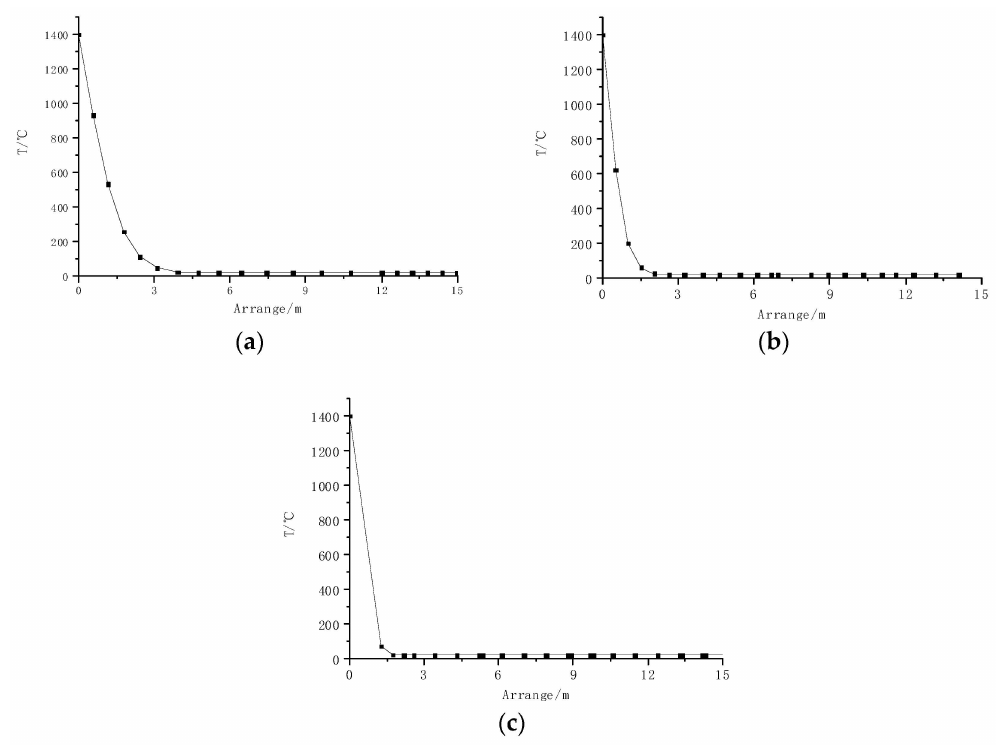
Figure 8. Temperature field distribution in the combustion cavity. ( a ) Roof temperature field distribu- tion. ( b ) Floor temperature field distribution. ( c ) Coal wall temperature field distribution.